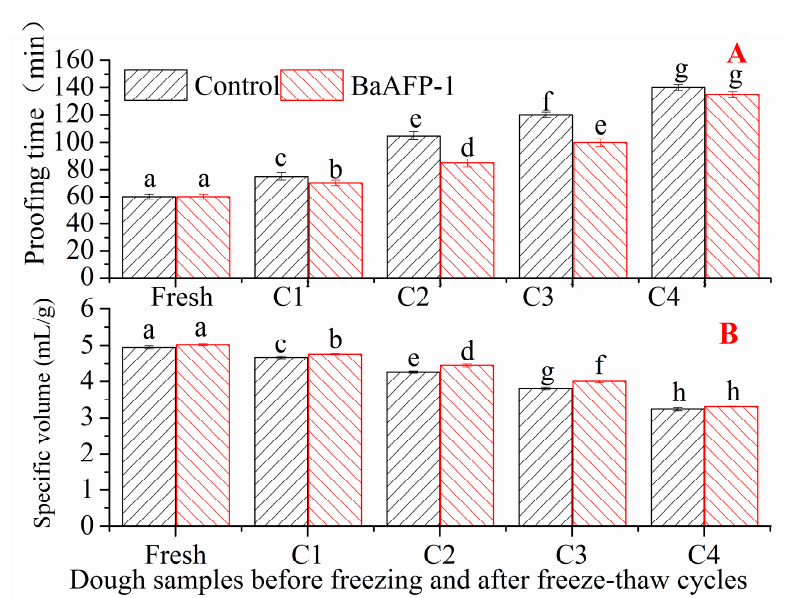
Figure 3. Effect of BaAFP-1 on the proofing time of dough samples ( A ) and specific volume of bread samples ( B ).